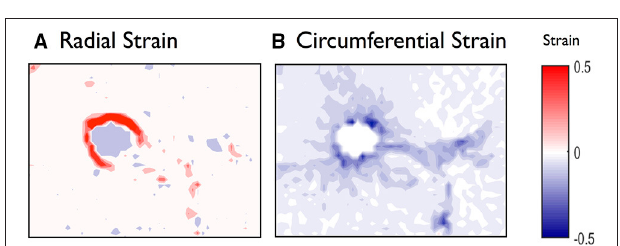
FIGURE 4 | Global analysis of the deformations of the mouse lung slice in Figure 1. (A) Radial (major) and (B) circumferential (minor) strains calculated by spatial derivation of the displacements and displayed as maps over the whole field. See Movie M3 (and Figures S3–S5 for analyses of additional PCLS) in Supplemental